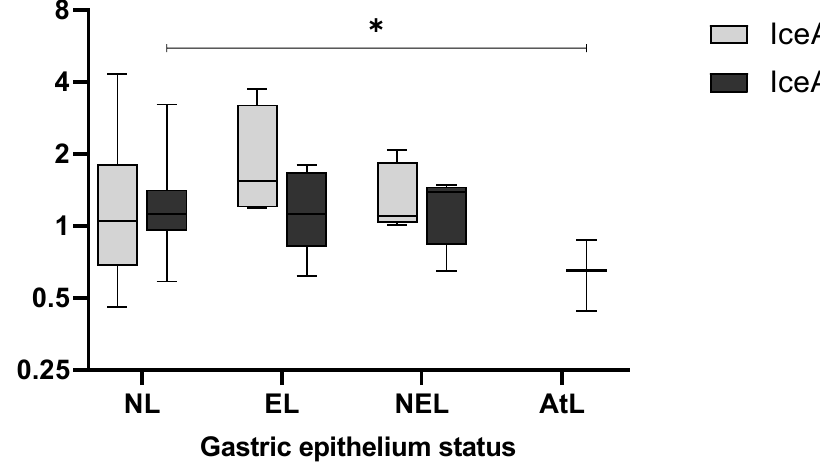
Figure 9. Genic expression of GRN in the different status of gastric tissue colonized with H. pylori iceA + . NL = epithelium without lesions; EL = erosive lesions; NEL = non-erosive lesions; AtL = atrophic lesions. Calculated GRN expression values by the formula 2 − ∆ Ct , being ∆ Ct = Ct of GRN − Ct of GAPDH . The virulence of H. pylori was detected by amplification of the iceA gene, by the PCR method, visualized on agarose gel (Cleaver Scientific, Rugby, UK). The status of the gastric tissue was determined according to the endoscopic observation report. The data was compared by non-parametric Kruskal–Wallis and Mann–Whitney tests for comparison between two variables. * Statistical significance p < 0.05.